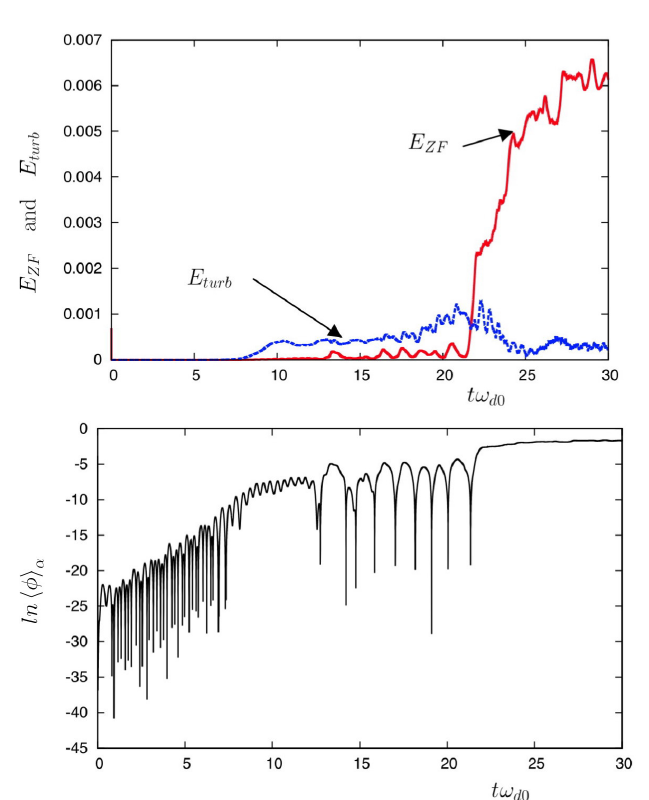
Figure 3. Time evolution of E turb (shown with the dotted and blue line) in the kinetic regime of zonal flow (ZF), in the top panel. In the bottom panel, the time evolution of the squared mean potential (cid:104) φ (cid:105) α in a logarithmic scale. There is a qualitative change in the interchange turbulence, which exhibits a weaker simultaneous growth of E ZF and E turb until saturation, at time t ω d 0 (cid:39) 25, and an oscillatory behavior of (cid:104) φ (cid:105) at low frequency. Here, the physical parameter is C i = 0.875. The corresponding α evolution of the zonal flow component (cid:104) φ (cid:105) is taken at ψ = 1 (in (cid:52) ψ α 2